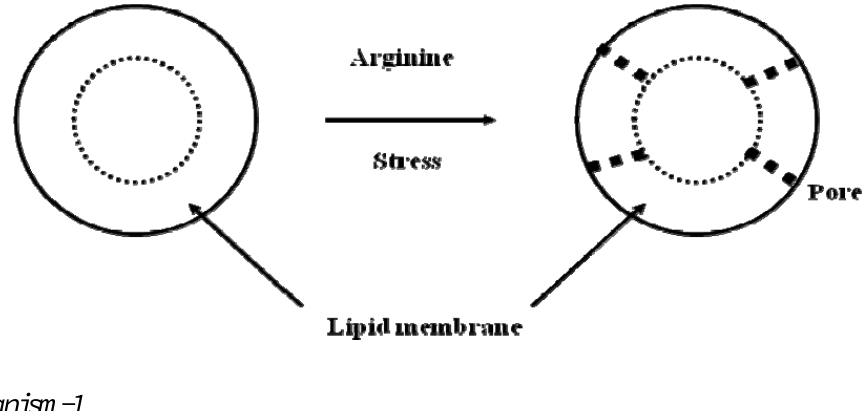
Figure 5. Virus inactivation mechanism-3: synergistic effect of arginine with other stresses causes pore formation in the lipidic viral